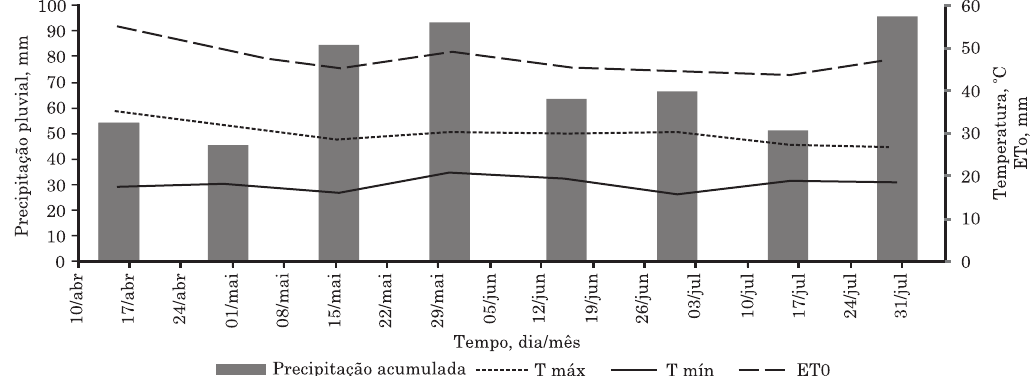
Figura 2. Distribuição temporal da precipitação pluvial total, temperaturas máxima e mínima e evapotranspiração (ETo) de referência, no período de abril a julho de